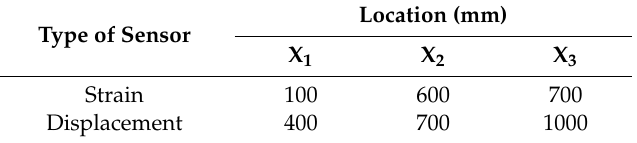
Table 8. The locations of sensor installation.